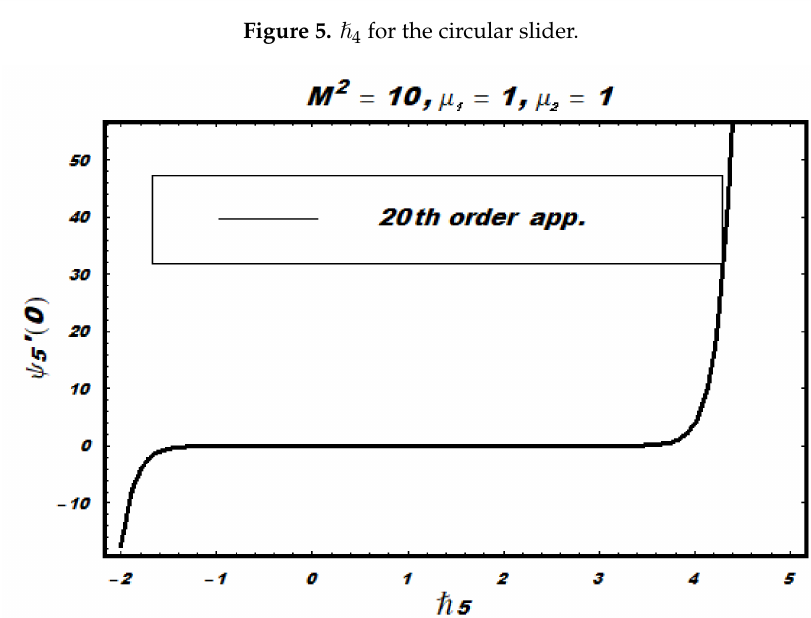
Figure 6. (cid:125) 5 for the circular